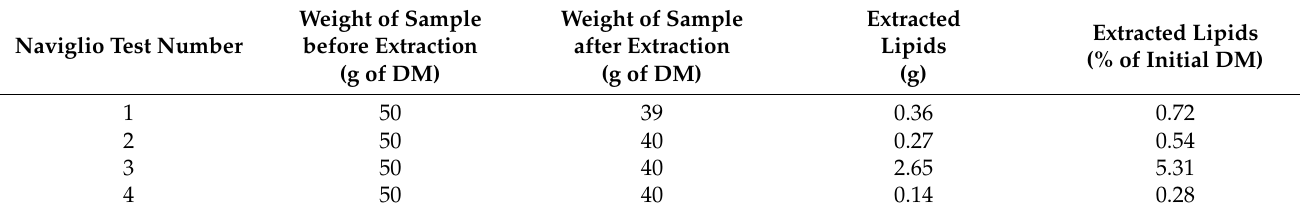
Table 2. Lipids contained in BSFL samples after extraction with the Naviglio